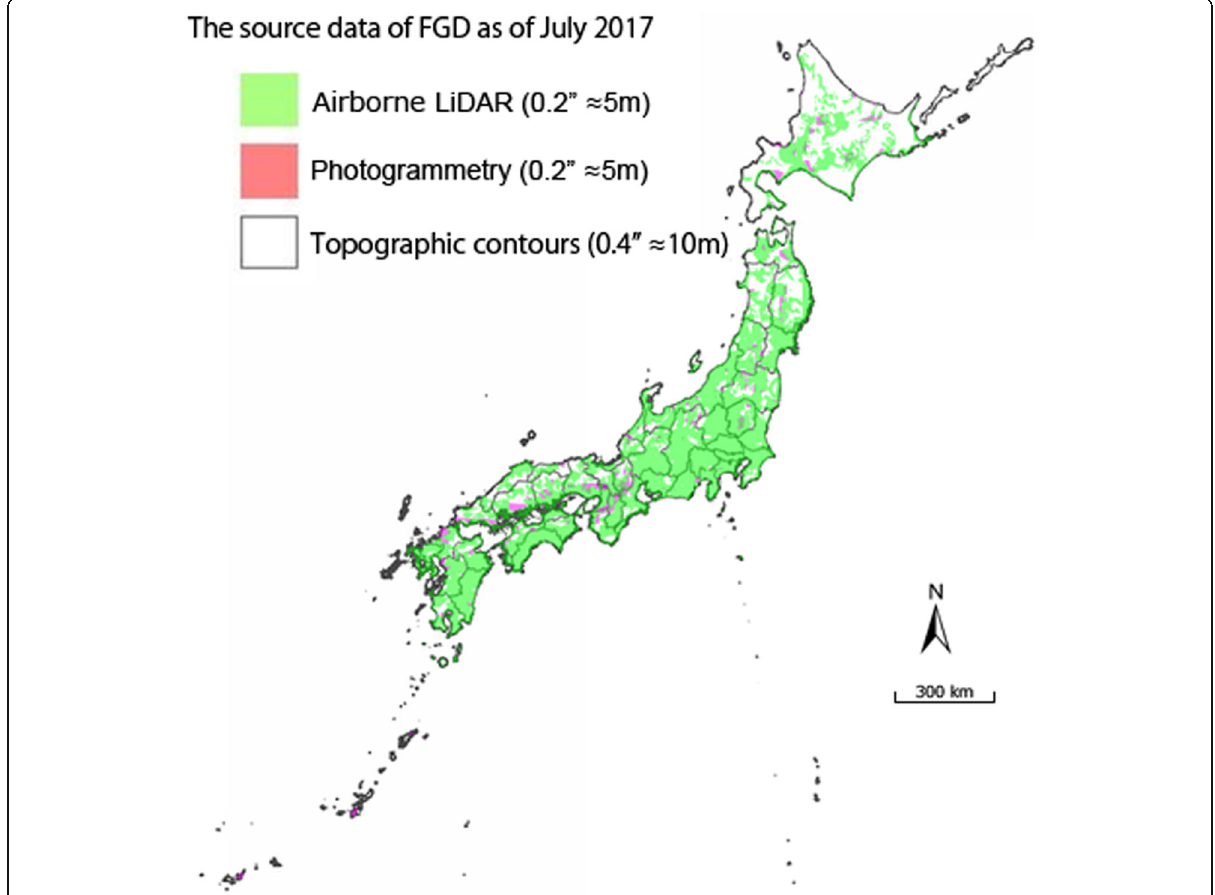
Fig. 6 Types of the source data of the DEM (FGD) used in this